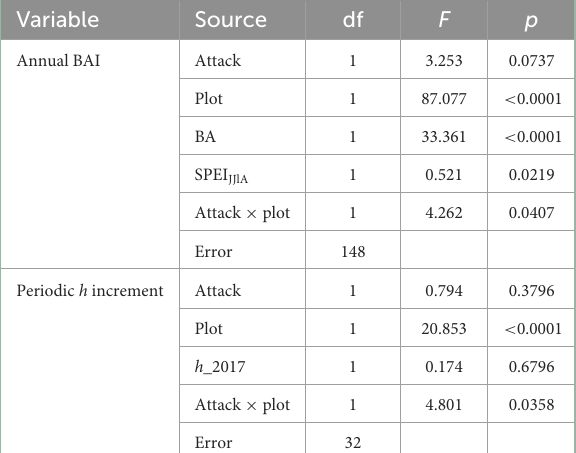
height increment for the two plots that include both attacked and unaffected